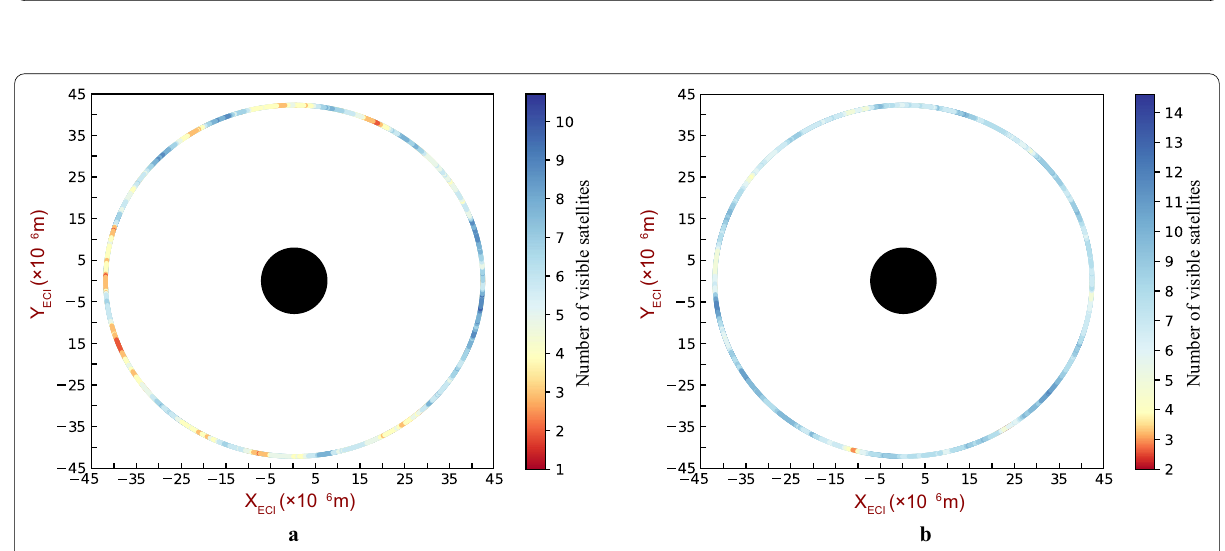
Galileo GLONASS BDS + + +